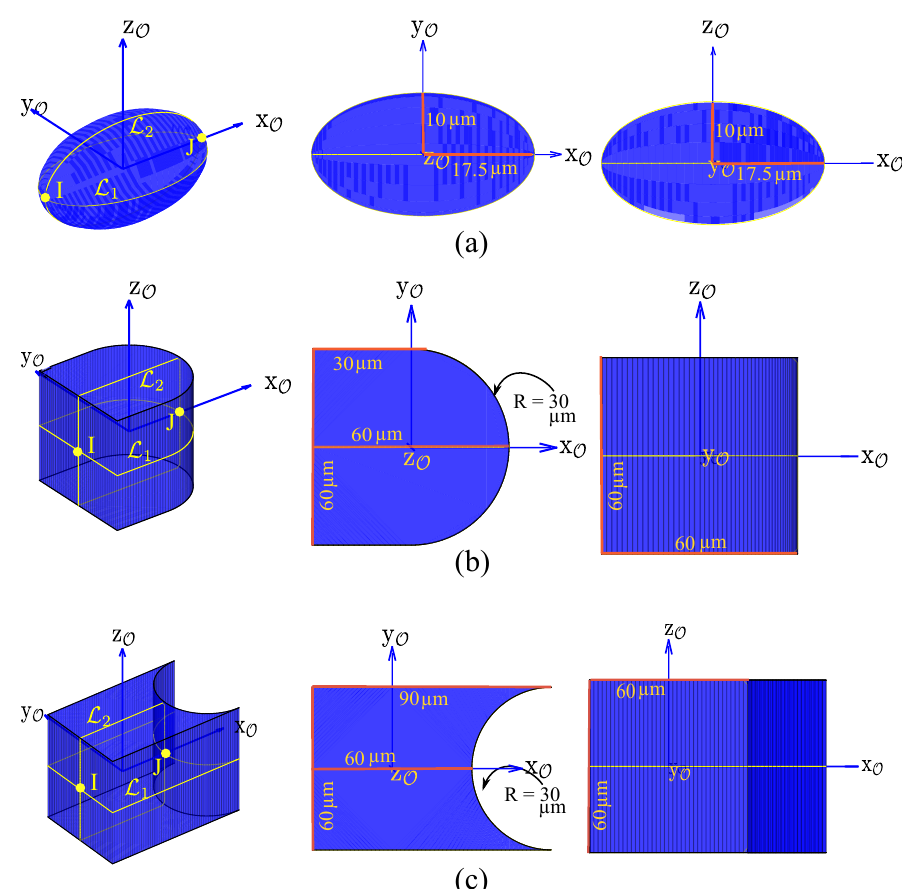
Figure 4. CAD model of various objects used for the simulations: ( a ) ellipsoid, ( b ) convex shaped object, ( c ) concave shaped object